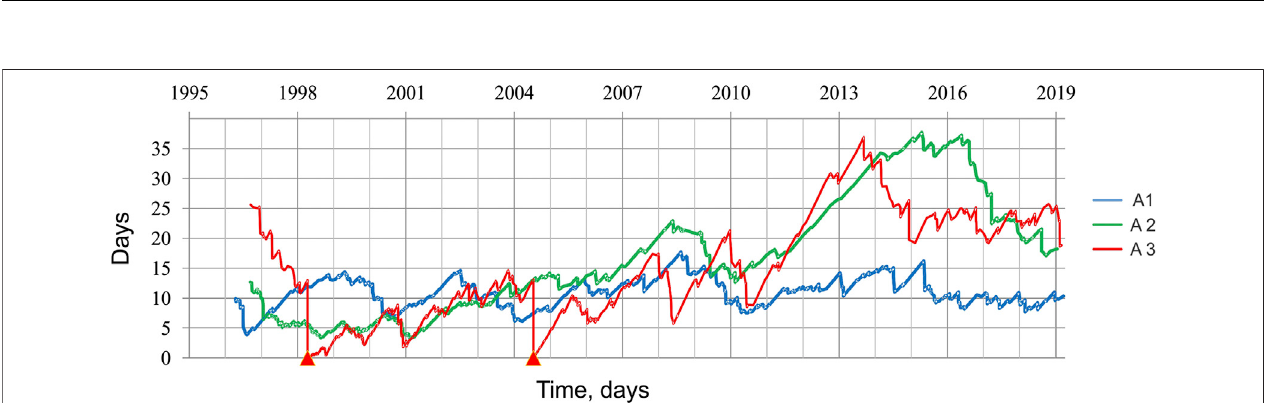
FIGURE 2 | Empirical cumulative distribution functions of (A) inter-event time ( τ , in days), (B) Benioff strain release ( Ʃ , in arbitrary units, a. u.), for M d ≥ 2.0 events, over the entire FVG territory (1995 – 2019) and the three sub-regions. Notes: FVG – black line, A1 sub-region – blue line, A2 sub-region – green line; A3 sub-region – red line.